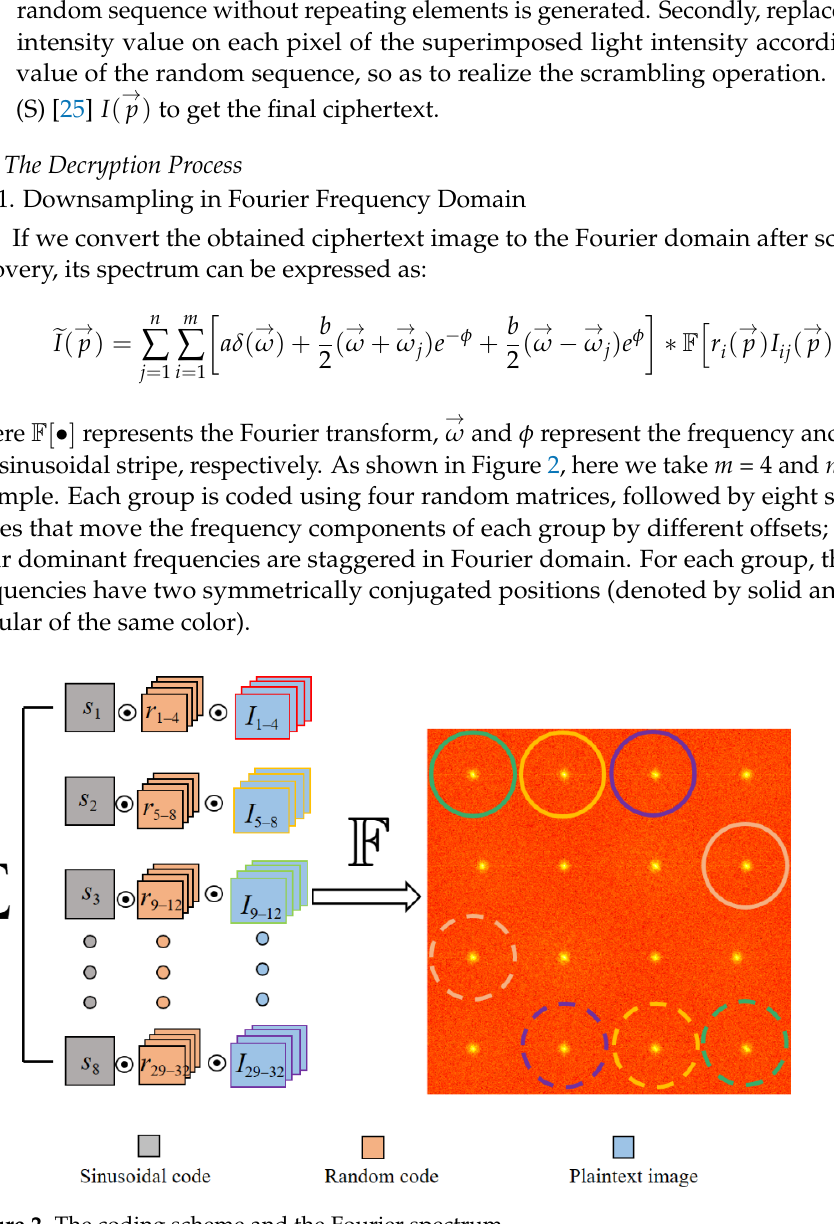
Figure 2. The coding scheme and the Fourier spectrum.